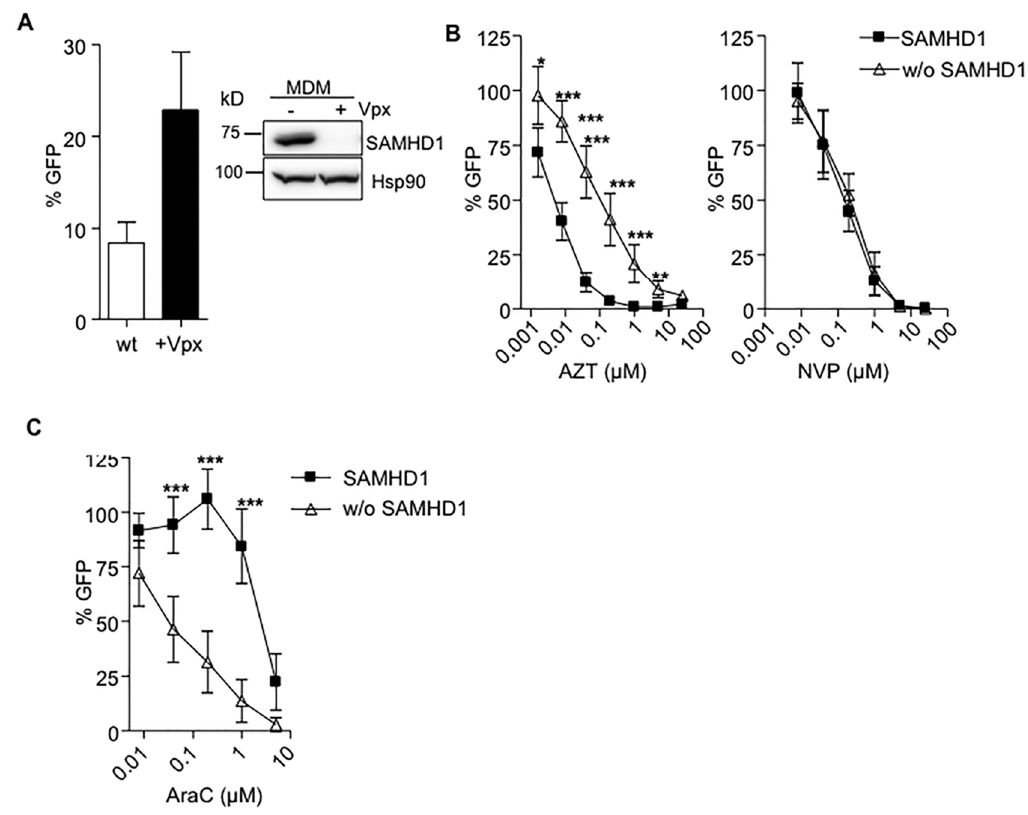
Figure 1. ( A ) Degradation of sterile alpha motif and histidine-aspartic acid domain-containing protein 1 (SAMHD1) by HIV-2 Vpx enhances HIV-1 replication in monocyte-derived macrophages (MDMs). MDMs previously treated or not with HIV-2 Vpx were infected with a VSV-pseudotyped HIV-1 GFP virus and replication assessed 2 days later by measuring GFP expression. A 5-fold change in HIV-1 replication was observed after Vpx-mediated SAMHD1 degradation. Mean ±SD of ten independent donors performed in duplicate is shown. A representative western blot showing degradation of SAMHD1 expression in MDMs after Vpx treatment is also shown. ( B ) Decreased sensitivity of AZT after Vpx-mediated SAMHD1 degradation in MDMs. Dose response of the NRTI AZT and NNRTIs NVP, in wild-type ( ■ ) or SAMHD1-depleted ( Δ ) MDMs. Inhibition of HIV infection was measured as the percentage of GFP+ cells relative to the no drug condition. Mean ±SD of at least ten independent donors performed in duplicate is shown. ( C ) SAMHD1 modifies antiviral activity of AraC. Dose response of the AraC in wild-type ( ■ ) or SAMHD1-depleted ( Δ ) MDM. Inhibition of HIV infection was measured as the percentage of GFP+ cells relative to the no drug condition. Mean ±SD of at least three independent donors performed in duplicate is shown. Mean ±SD of at least three independent experiments performed in triplicate is shown. * p < 0.05; ** p < 0.005; *** p < 0.0005.